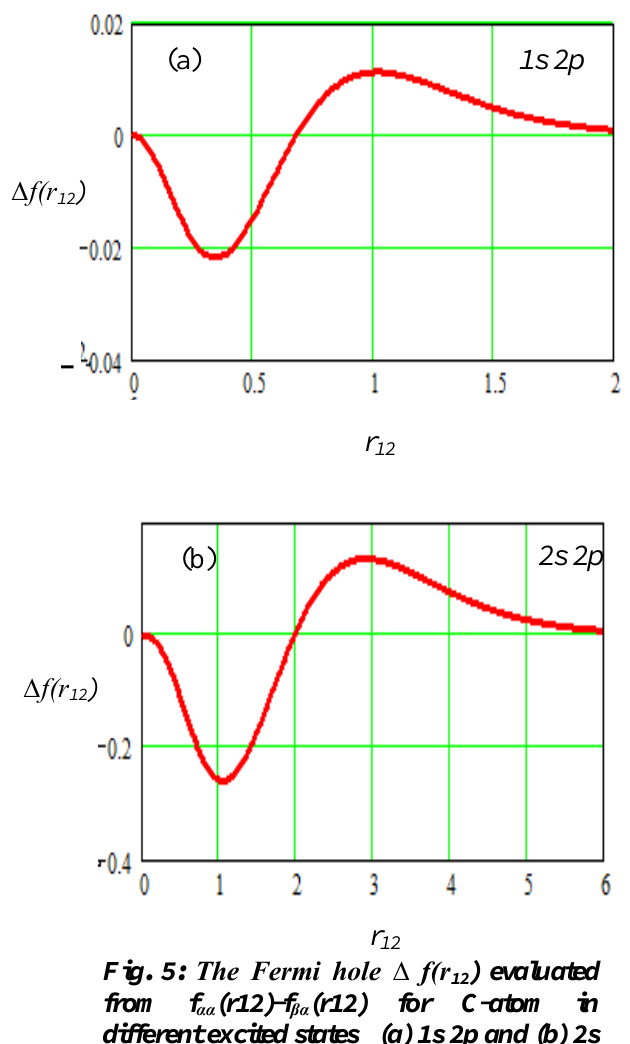
Fig. 5: The Fermi hole ∆ f(r from f (r12)-f (r12) for C-atom in αα βα different excited states (a) 1s 2p and (b) 2s